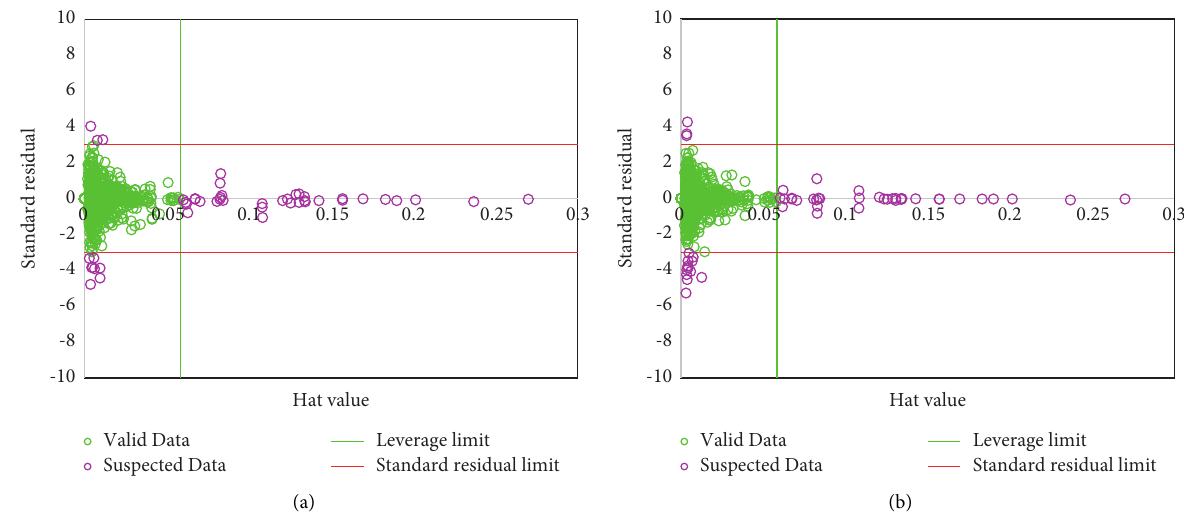
Figure 4: Williams’s analysis to determine suspicious points for models (a) PSO-ANN and (b) GA-ANN.